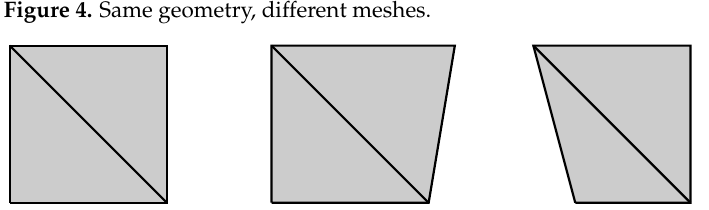
Figure 5. Same mesh topology, different